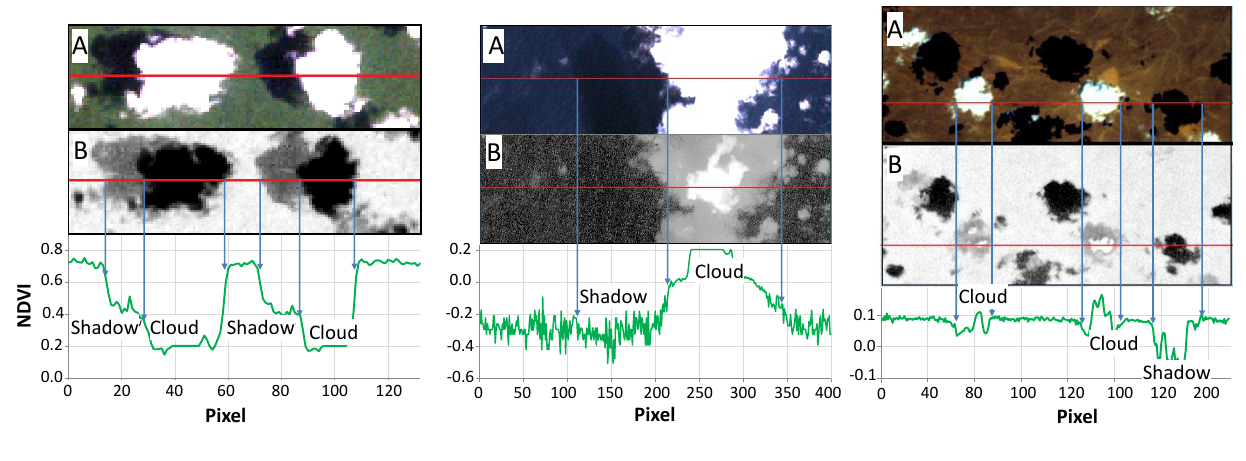
Figure 1. Clouds and cloud shadows and their effects on NDVI. Left: over vegetated land surface, middle: over water surface, right: over bare land surface. These sites are randomly selected. ( A ) True color Landsat-7/ETM+ image. ( B) Landsat-7/ETM+ NDVI image.